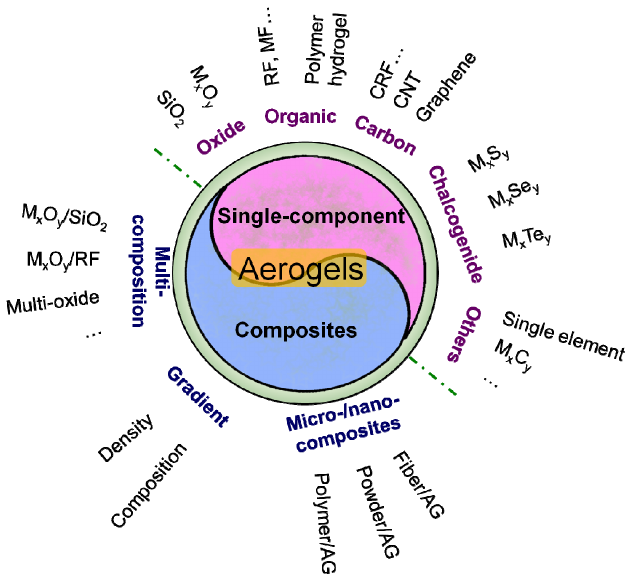
Figure 2. The classification of the